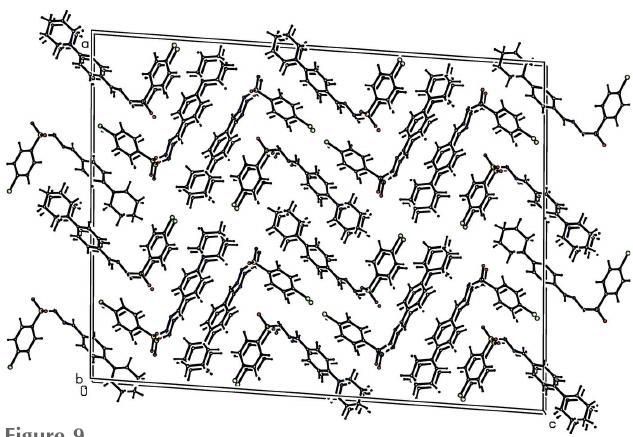
Table 3 Hydrogen-bond geometry (A˚ , (cid:4) ) for (III).